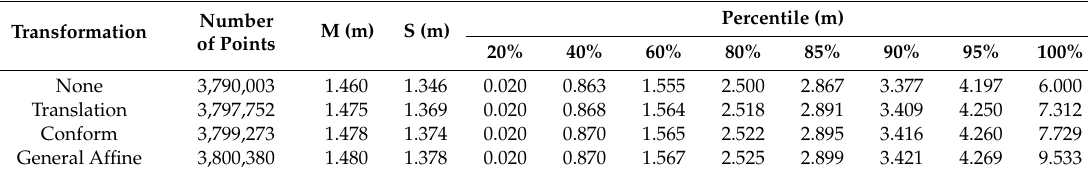
Table 1. Points distance statistics for the whole Lombardy